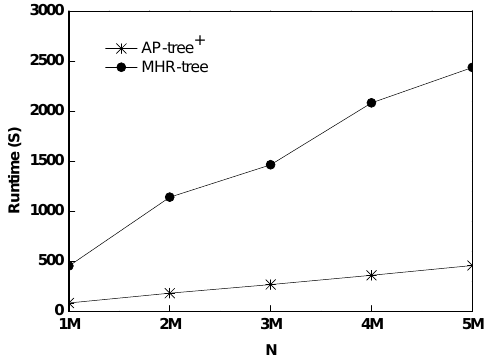
Figure 12. The CPU runtime of AP-tree + comparing with